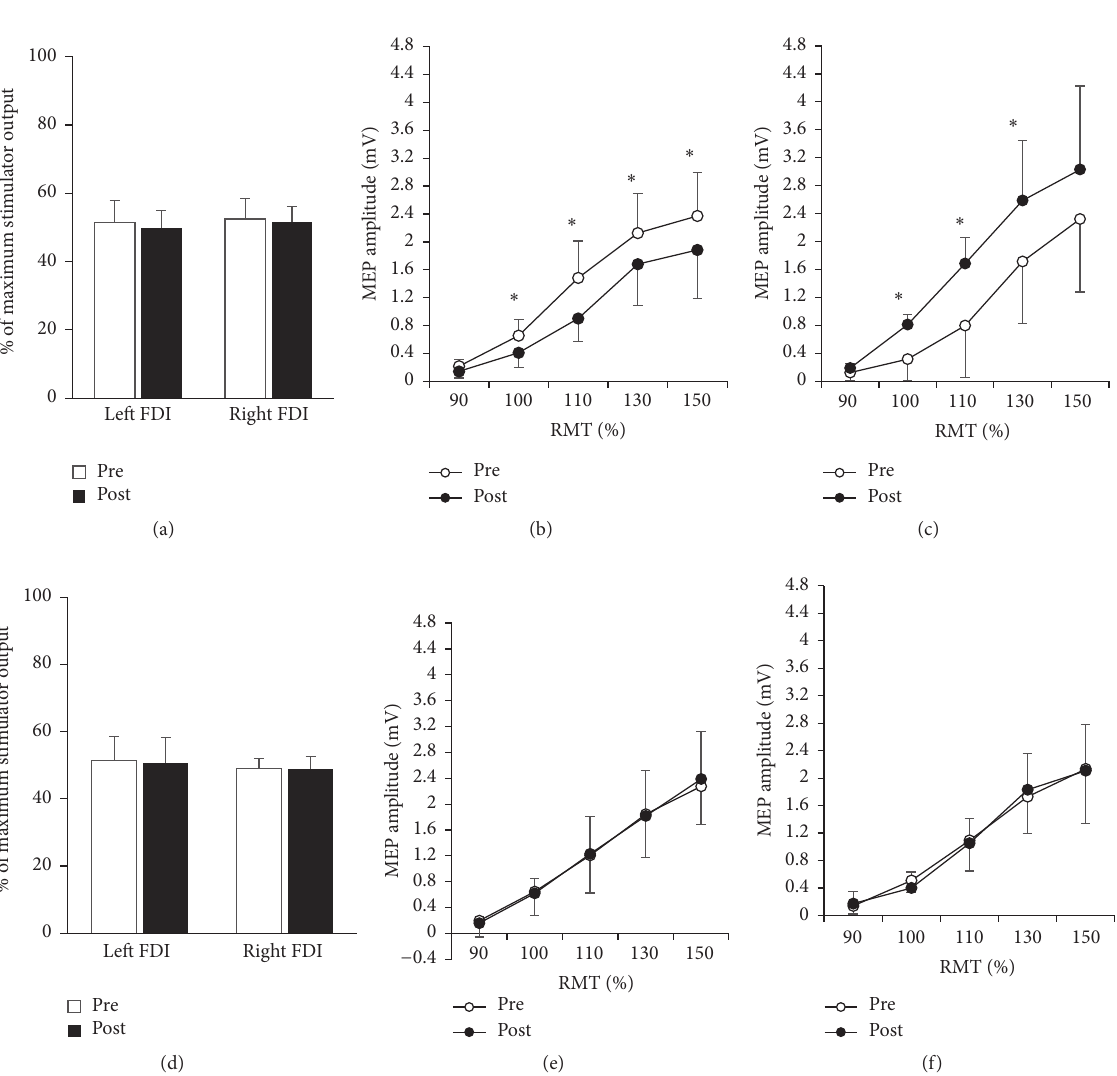
Figure 1: TMS properties of intervention-induced plasticity. (a–c) Effects of acupuncture on TMS variables. (a) Motor thresholds (mean ± SD). Acupuncture affected the RMT of neither the contralateral nor ipsilateral FDI of acupuncture ( 𝑃 > 0.5 ). Preintervention (open bars); postintervention (filled bars). (b) The recruitment curve (mean ± SEM) from the left FDI (ipsilateral FDI of acupuncture). The ordinate gives the MEP size in mV; the abscissa shows the stimulus intensity relative to RMT. Preintervention ( I ); postintervention ( e ). Significantly smaller MEPs were elicited at intensities greater than 90% RMT after acupuncture. (c) The recruitment curve (mean ± SEM) from the right FDI (contralateral FDI of acupuncture). Significantly larger MEPs were elicited at intensities 100%, 110%, and 130% RMT after acupuncture. (d–f) Variables by the control intervention. (d) Motor thresholds (mean ± SD). RMT in neither the left FDI nor the right FDI was altered by the control period. (e) The recruitment curve (mean ± SEM) from the left FDI. No significant changes of MEP amplitude were elicited by the control period. (f) The recruitment curve (mean ± SEM) from the right FDI. No significant changes of MEP amplitude were elicited by the control period. ∗ 𝑃 < 0.01 (Bonferroni’s post hoc